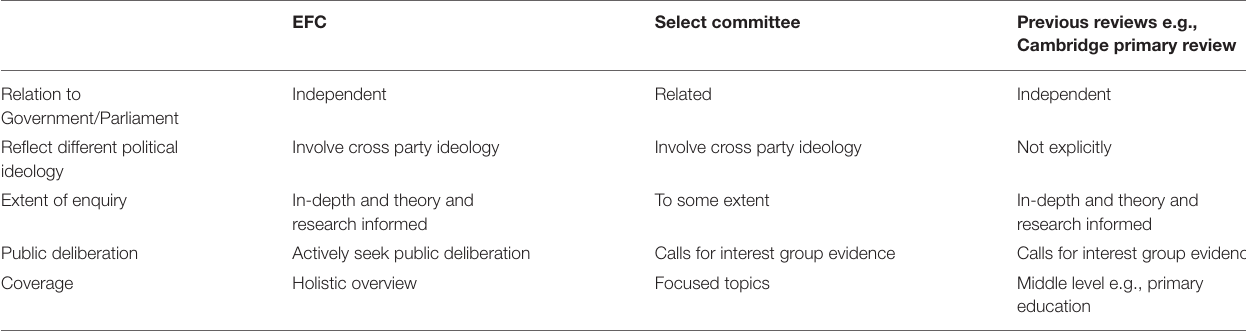
TABLE 1 | Key points about EFC in relation to Select Committees and Previous Education